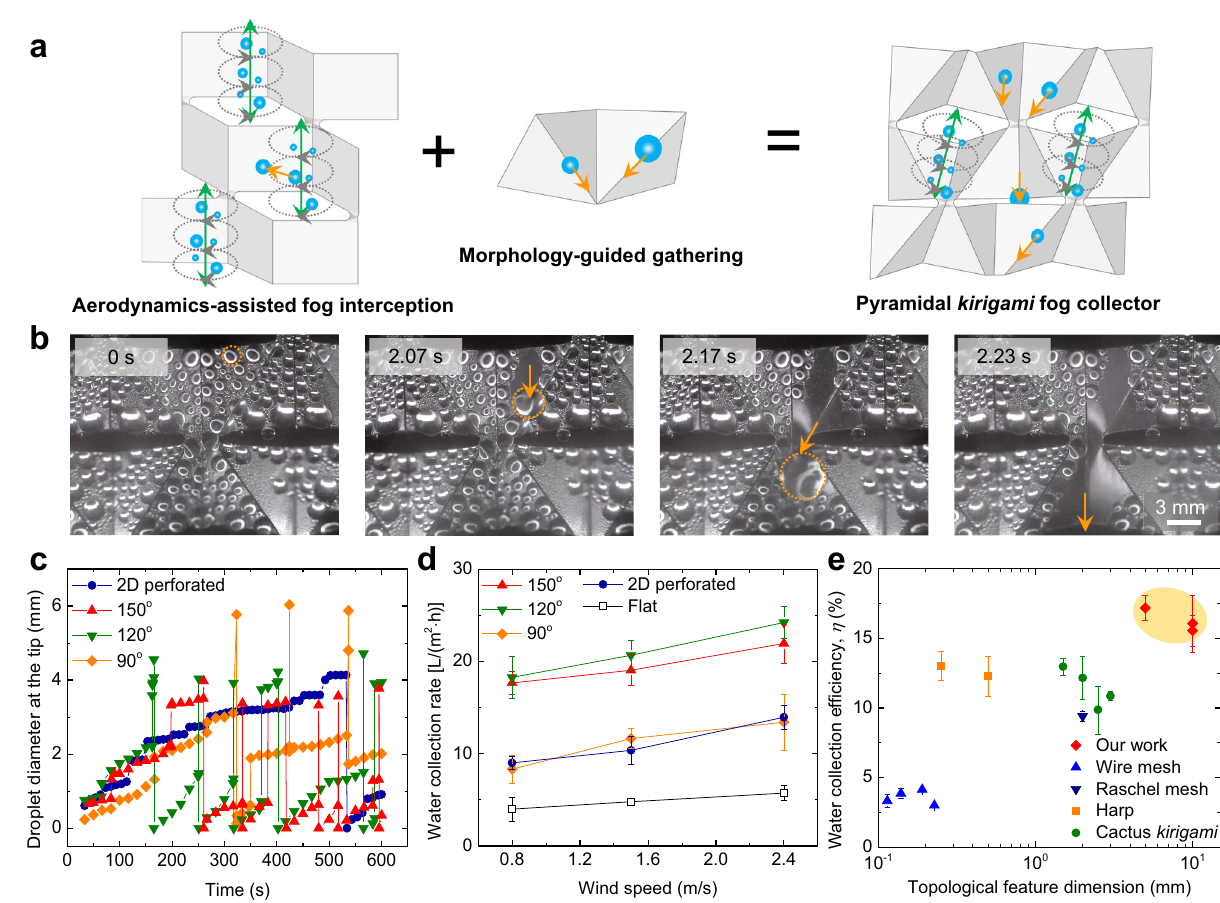
Fig. 3 The ef fi cient dripping and collection of fog droplets on the pyramidal kirigami . a The design of pyramidal kirigami structure for highly ef fi cient fog collection. It combines the aerodynamics-assisted fog interception induced by the geometric curvature with the directed droplet gathering arising from the asymmetric morphology. b Selected snapshots of the transport and dripping of droplets recti fi ed by the valley folds. c Time evolution of the droplet diameter sitting at the bottom tip of concave pyramid. The sudden drop of droplet diameter indicates the dripping of droplets. d The variation of stabilized water collection rate as a function of wind speed and folding angle. e The comparison of the collection ef fi ciency ( η ) of various fog collectors. Here, θ = 150°. Data in ( d , e ) are means ± s.d. of fi ve